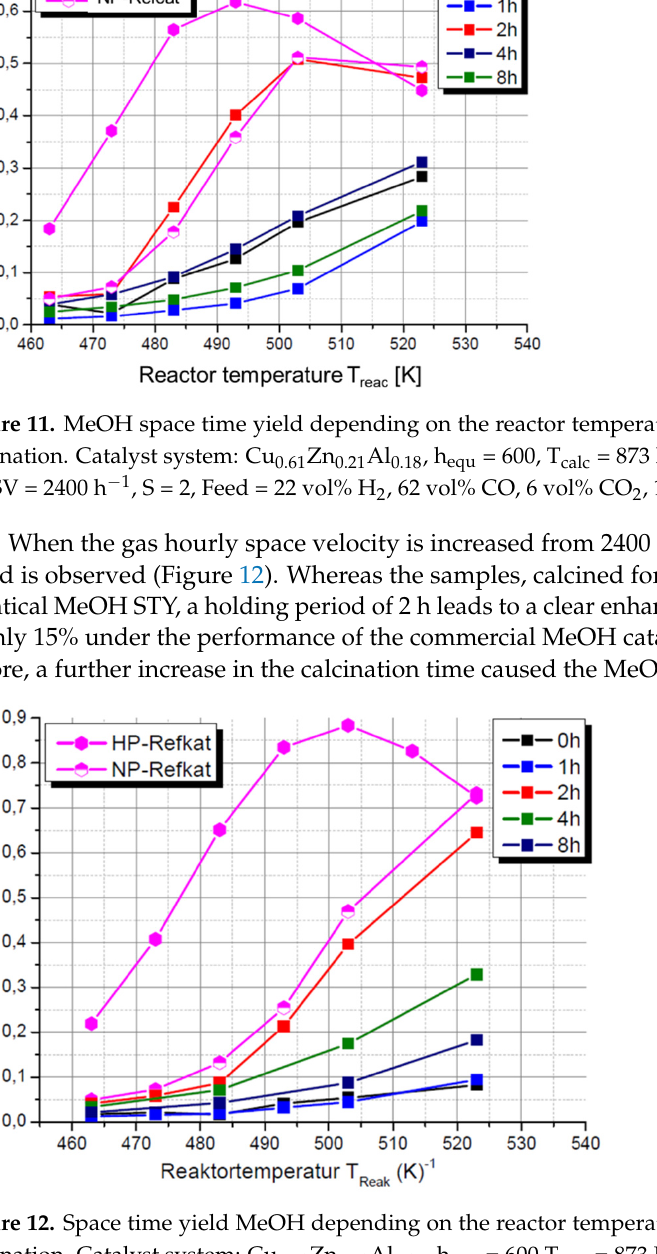
Figure 12. Space time yield MeOH depending on the reactor temperature and the duration of the calcination. Catalyst system: Cu 0.61 Zn 0.21 Al 0.18 , h equ = 600 T calc = 873 K. Catalytic tests: p = 5 MPa, GHSV = 4000 h − 1 , S = 2, Feed = 22 vol% H 2 , 62 vol% CO, 6 vol% CO 2 , 10 vol% Ar.